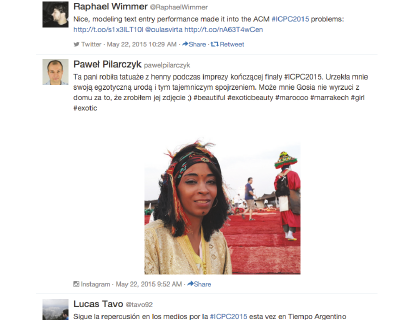
Figure 6: MyICPC master timeline.